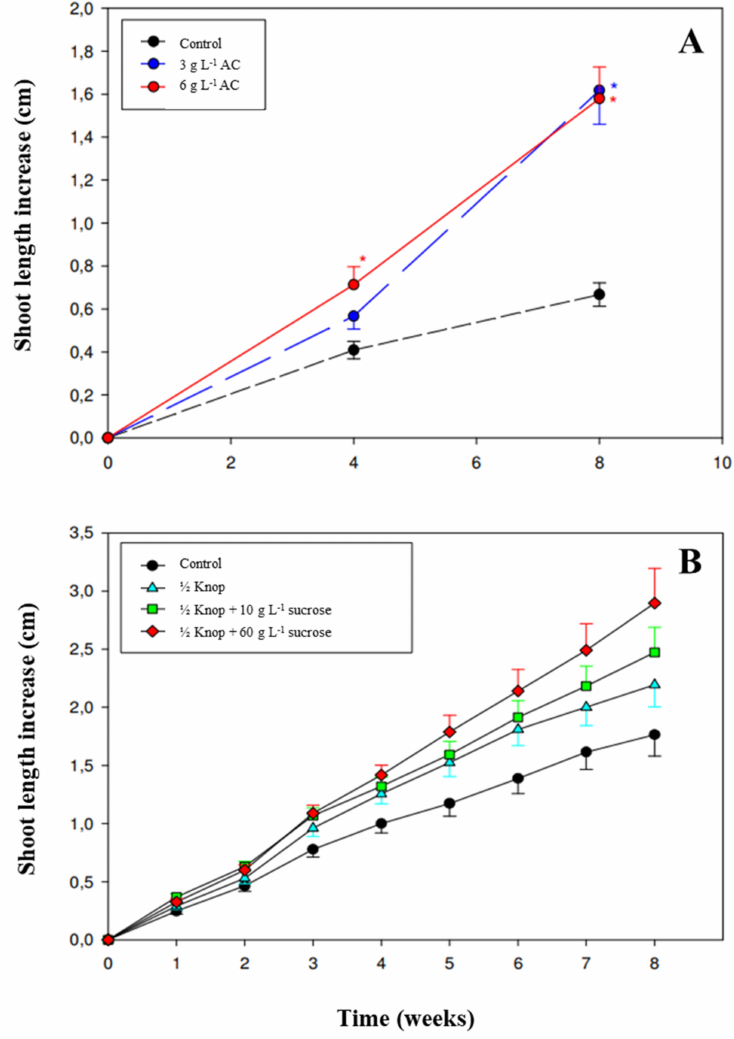
Figure 2. Effect of a Double-Phase Culture System (DPS) on shoot length of Tetraclinis articulata (Vahl) Masters explants. ( A ) The effect of two concentrations (3 and 6 g L − 1 ) of activated charcoal (AC) contained in a liquid overlay was tested in a first experiment. ( B ) The effect of 1 and two concentrations of sucrose (10 and 60 g L − 1 ) present in the overlay was tested in a second experiment. * Indicates significant differences at 5% in comparison to control as revealed by Duncan’s multiple range test. Data are presented as means ±